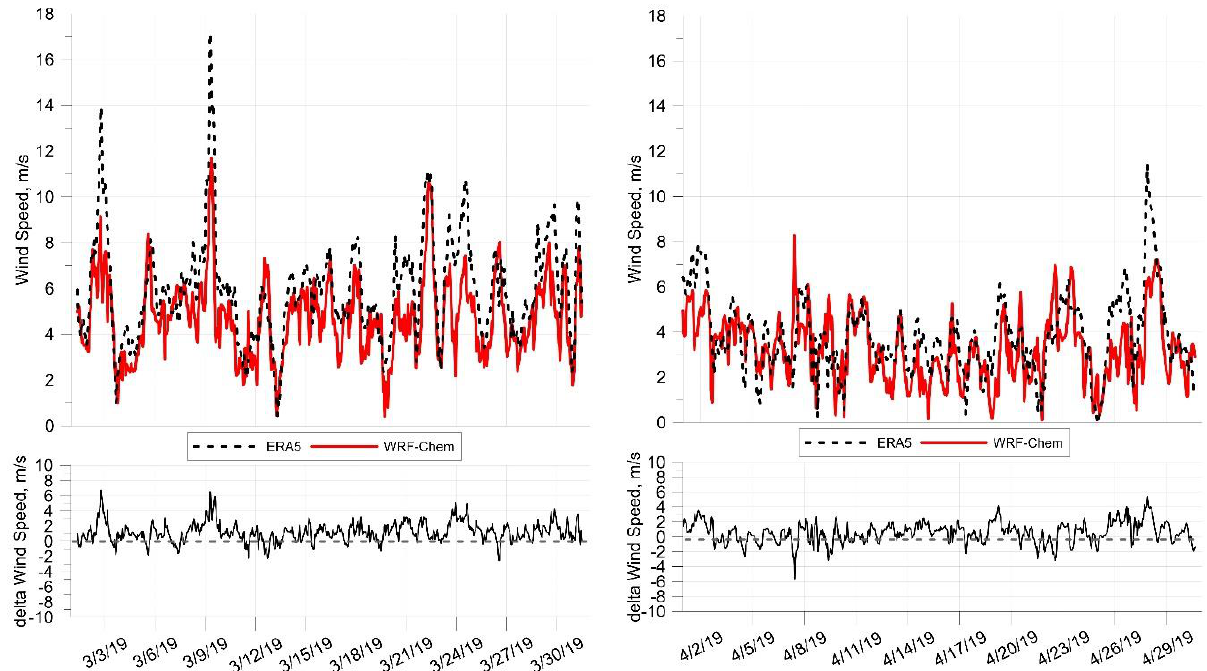
Figure 5. Temporal variation in wind speed at 10 m and differences according to the ERA5 and WRF-Chem data in March ( left ) and April ( right ) 2019 in the territory of Peterhof (Saint Petersburg).